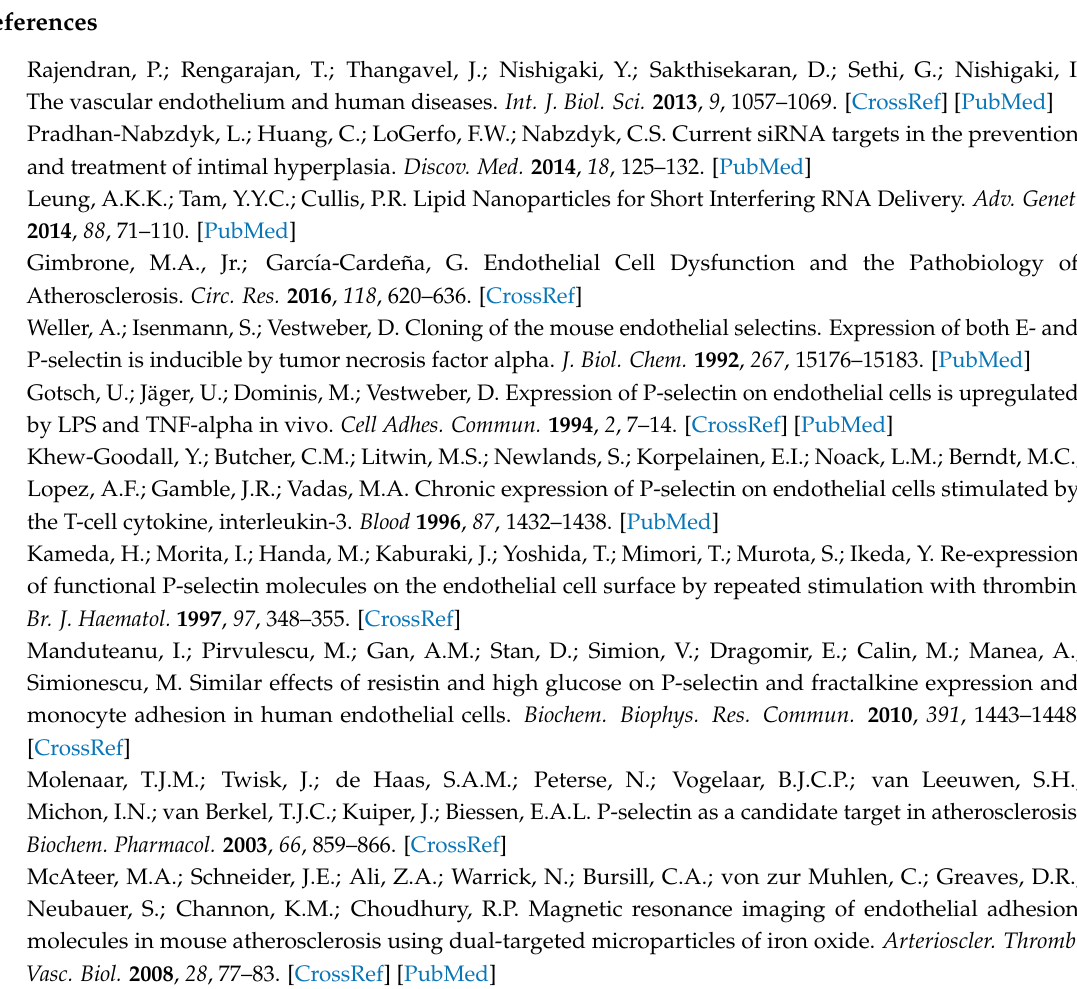
Figure S1: The expression of GAPDH and β -actin mRNA in b.End3 cells determined at 48 hours after transfection with different lipoplexes at a charge ratio +/ − of 4 and 100 nM siRNA. Legend: Scr-lipo: non-targeted liposomes; Psel-lipo: P-selectin targeted liposomes; scr-siRNA: scrambled siRNA; siRNA-GAPDH: siRNA specific for GAPDH; siPORT: siPORTTM NeoFX transfection